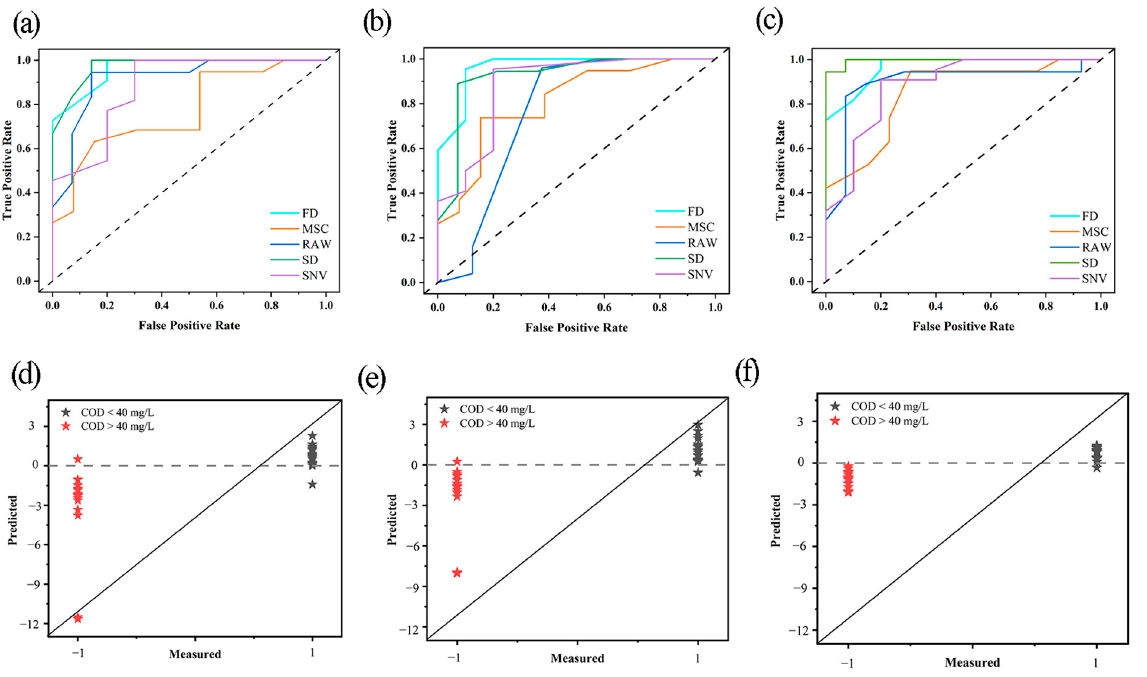
Figure 4. Receiver operating characteristic (ROC) curves and surface water score map: ( a , d ) partial least squares discriminant analysis (PLS–DA) model, ( b , e ) synthetic minority oversampling technique (SMOTE)–PLS–DA model, ( c , f ) competitive adaptive reweighted sampling (CARS)–SMOTE–PLS–DA model. FD: first derivative; SD: second derivative; MSC: multiple scattering correction; SNV: standard normal variate.